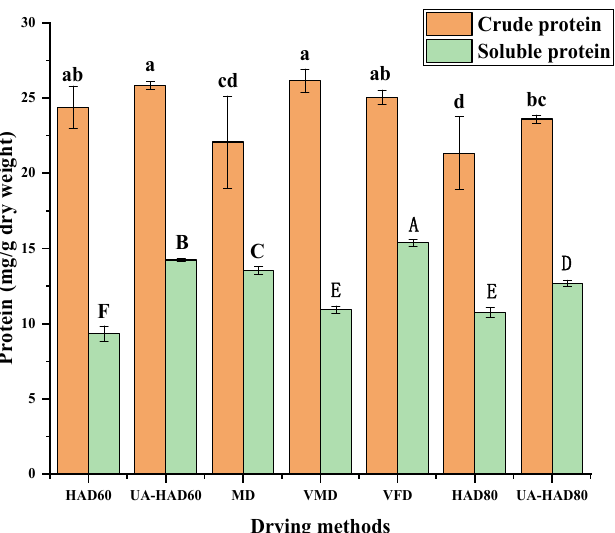
Figure 3. The protein contents of O. raphanipes subjected to different drying methods. Different letters in the same line indicate significant difference ( p < 0.05). Capital letters indicate significance analysis for soluble protein content and small letters indicate significance analysis for crude protein content. HAD60—60 °C hot air drying, HAD80—80 °C hot air drying, UA-HAD60—ultrasonic-as-